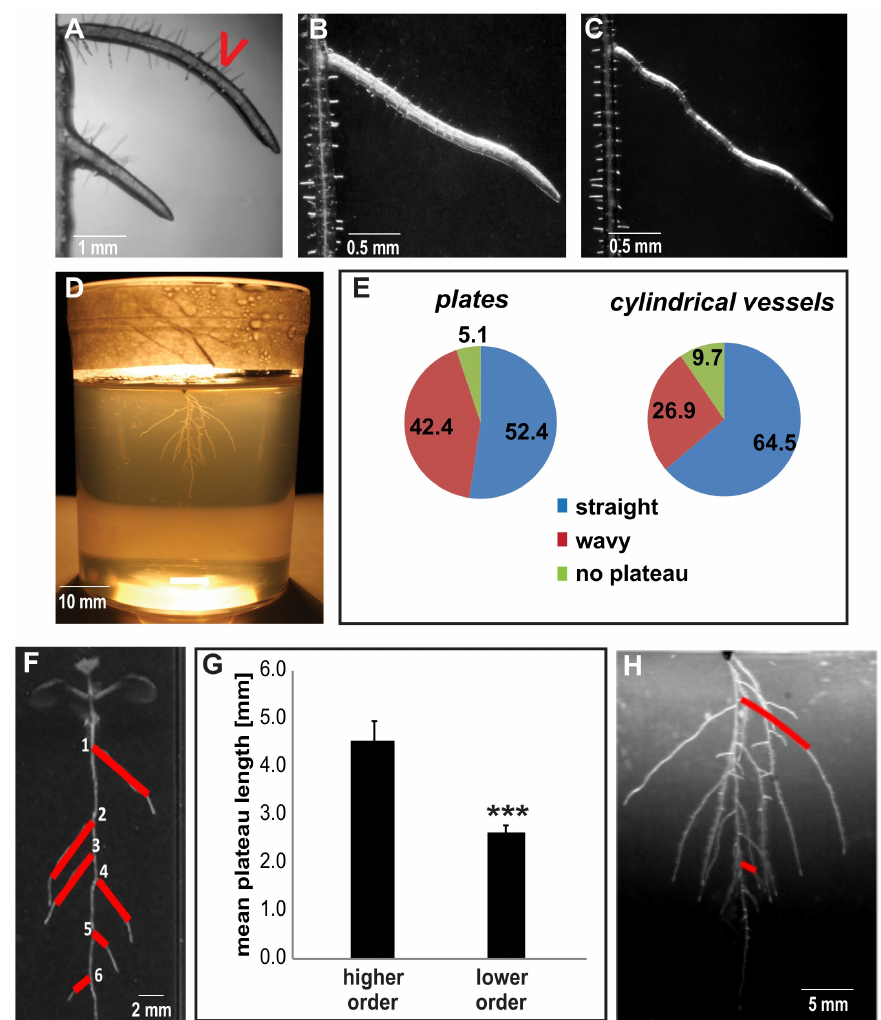
Figure 2. Characterization of the plateau phase. ( A ) A low percentage of LRs displayed a continuous decline of GSA throughout development (“no plateau”); notice the contrast between the upper LR (no plateau) and the bottom LR (in plateau phase). ( B , C ) Growth during the plateau phase may show some degree of waviness; compare with “straight” LR growth in ( A ) (bottom LR). The degree of waviness during plateau varies (LR depicted in ( C ) shows more waviness than LR depicted in ( B ). ( D ) A representative 20-DAG (days after germination) wild type seedling (Col-0), grown in a cylindrical vessel (3D model). ( E ) The incidence of waviness during plateau is lower in seedlings that grow within the agar (cylindrical vessels), compared to seedlings grown on the surface of a medium (plates). Percentages from a representative experiment are given ( ≥ 150 LRs; ≥ 30 seedlings). ( F , G ) Plateau segments (red lines in ( F ) of higher order LRs (1–3) are typically longer than those of younger or lower order LRs (4–6 in the example). Average values of plateau length were obtained for higher (1–3) and lower order LRs (4-) for individual Col-0 seedlings ( G ). Representative experiments are shown. Error bars represent SEM ( n > 30 seedlings per experiment). *** p < 0.001 (Student’s t -test). A Representative 14-DAG Col-0 seedling is shown in ( F ). ( H ) Higher order LRs also display longer plateau (red lines) in the 3D growth model. A magnification of the seedling in ( D ) is shown. Red lines depict the plateau